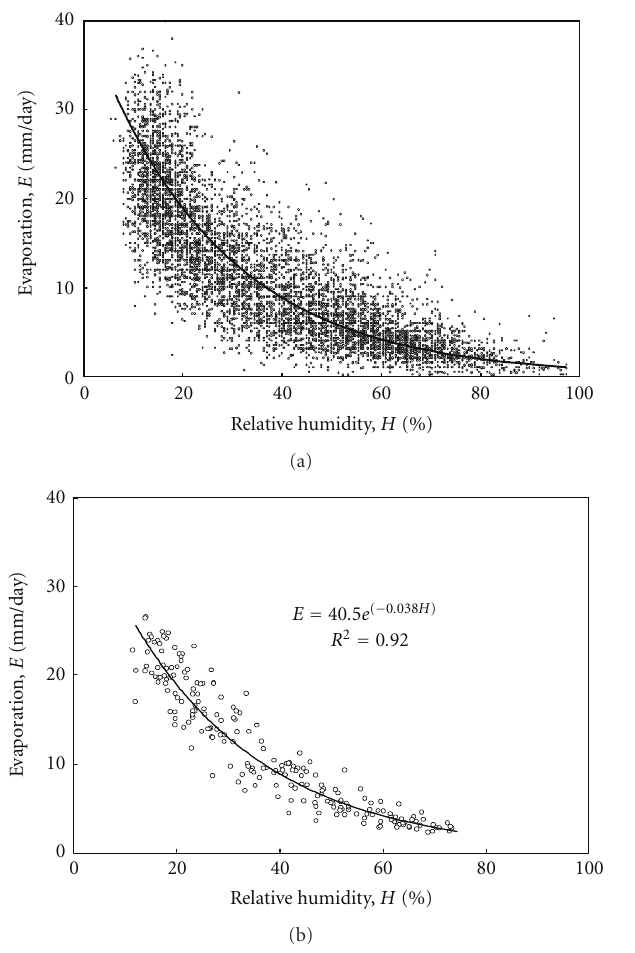
Figure 3: Evaporation as a function of relative humidity for the data of Kuwait from 1993 to 2009. The solid curves represent suggested relations fitted using regression analysis. (a) Daily average data; (b) monthly average data.